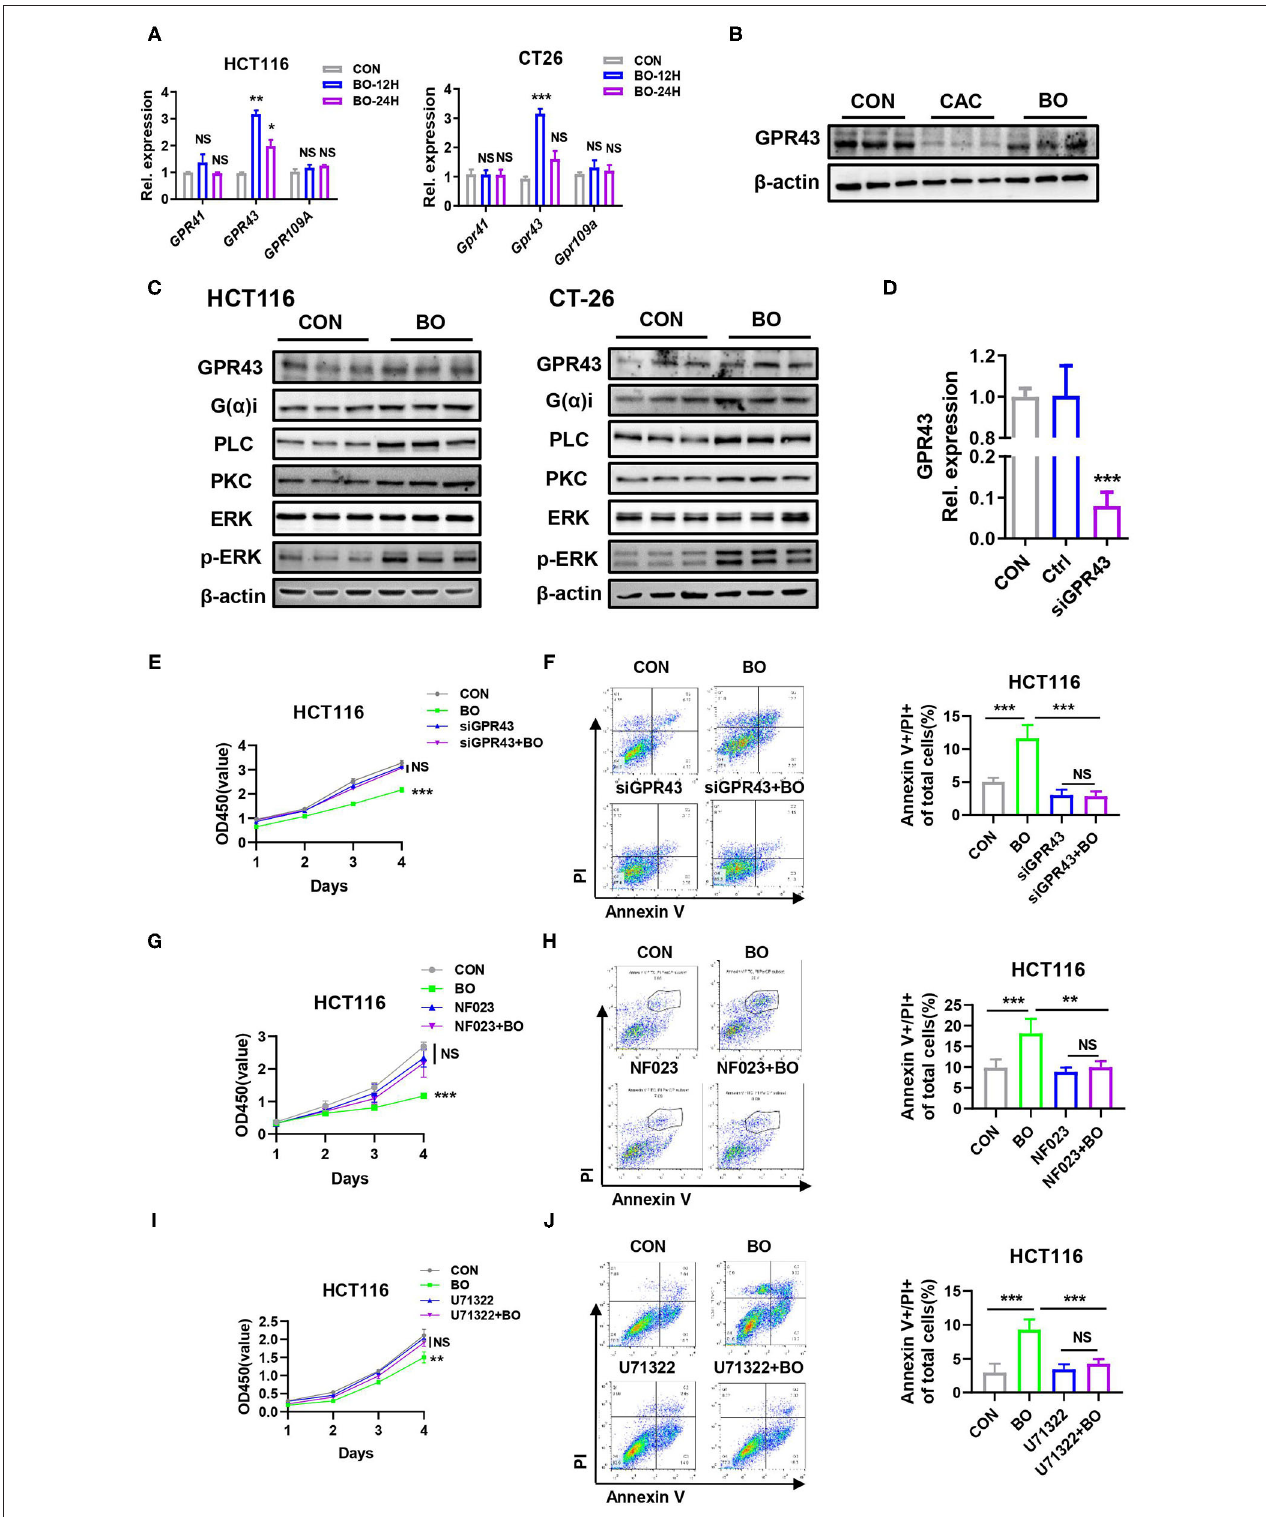
FIGURE 6 | A GPR43 is a targeted receptor of BO in suppressing CRC proliferation. (A) The HCT116 cells and CT26 cells were treated with BO for 12 and 24h (MOI = 5). The mRNA expressions of GPR41 , GPR43 , and GPR109A in the HCT116 cells and CT26 cells were detected by qPCR. (B) The mice were treated as described in Figure 1A . The tumor tissues were separated. The protein levels of GPR43 in tumors tissues were detected by the western blots. (C) The HCT116 cells and CT26